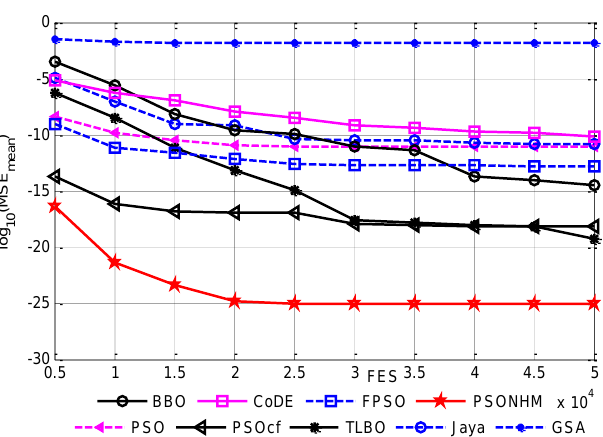
Figure 7. Convergence curves of nine algorithms for the Balloon dataset.